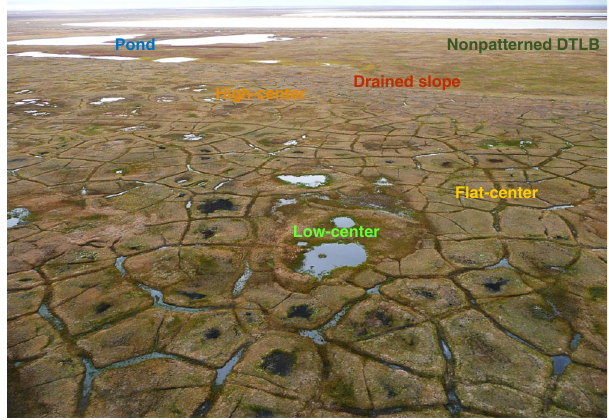
Fig. 2 Oblique aerial photograph of the dominant polygonal tundra landforms on the Arctic Coastal Plain of Alaska. Photograph acquired in August 2008 from southeast (~135° azimuth) of 71°16 ’ 46.02 ” N, 156° 25 ’ 45.35 ”